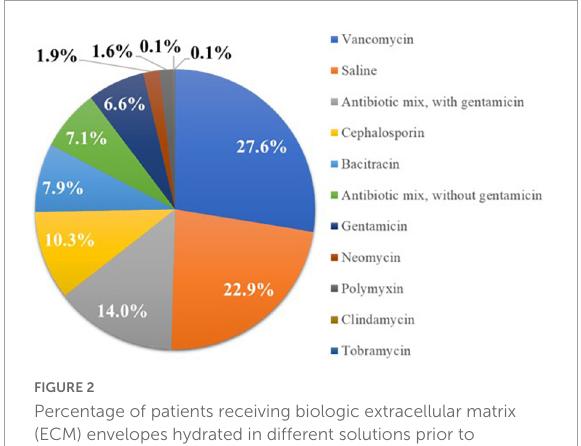
FIGURE2 Percentage of patients receiving biologic extracellular matrix (ECM) envelopes hydrated in different solutions prior to implantation. Most implanting physicians chose envelope hydration solutions containing